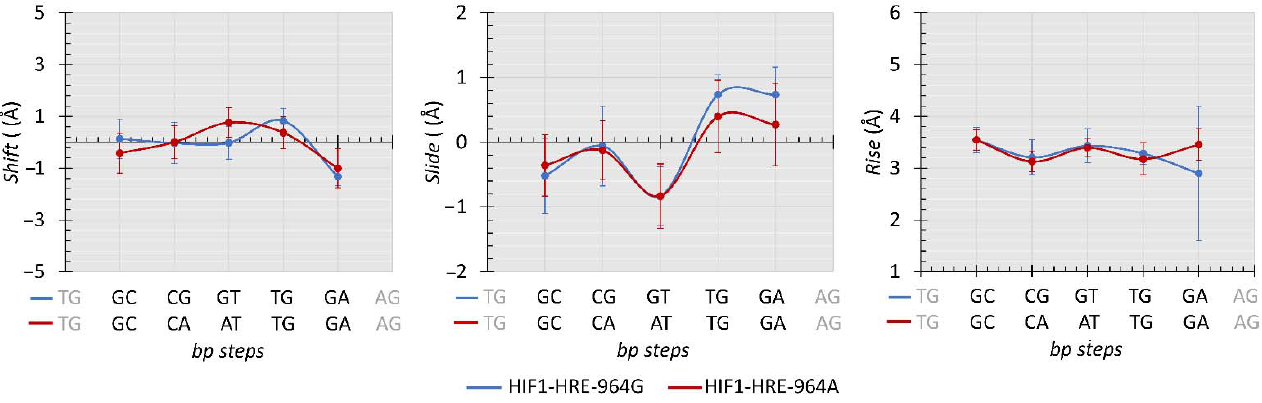
Figure 8. Average values (Å) comparisons regarding the shift, slide, and rise calculated for the HRE from HIF1-HRE-964G/A complexes trajectory atomic coordinates every 10 ns. Note: Author’s own image.